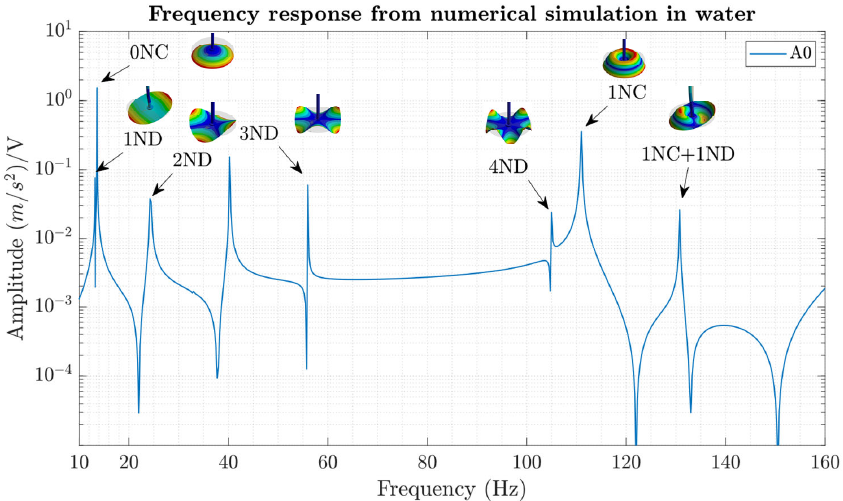
Figure 15. Numerical frequency response obtained from a harmonic analysis of the non-rotating disk in water.